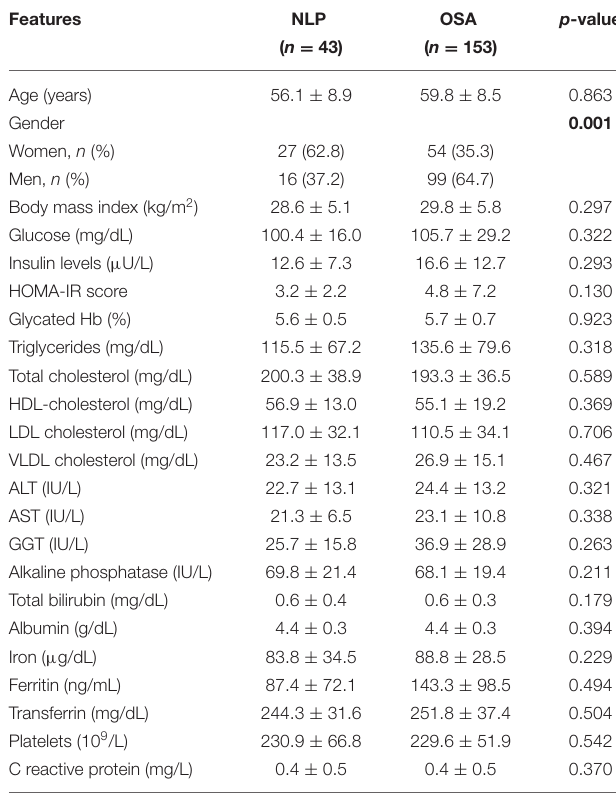
TABLE 1 | Characteristics of the study